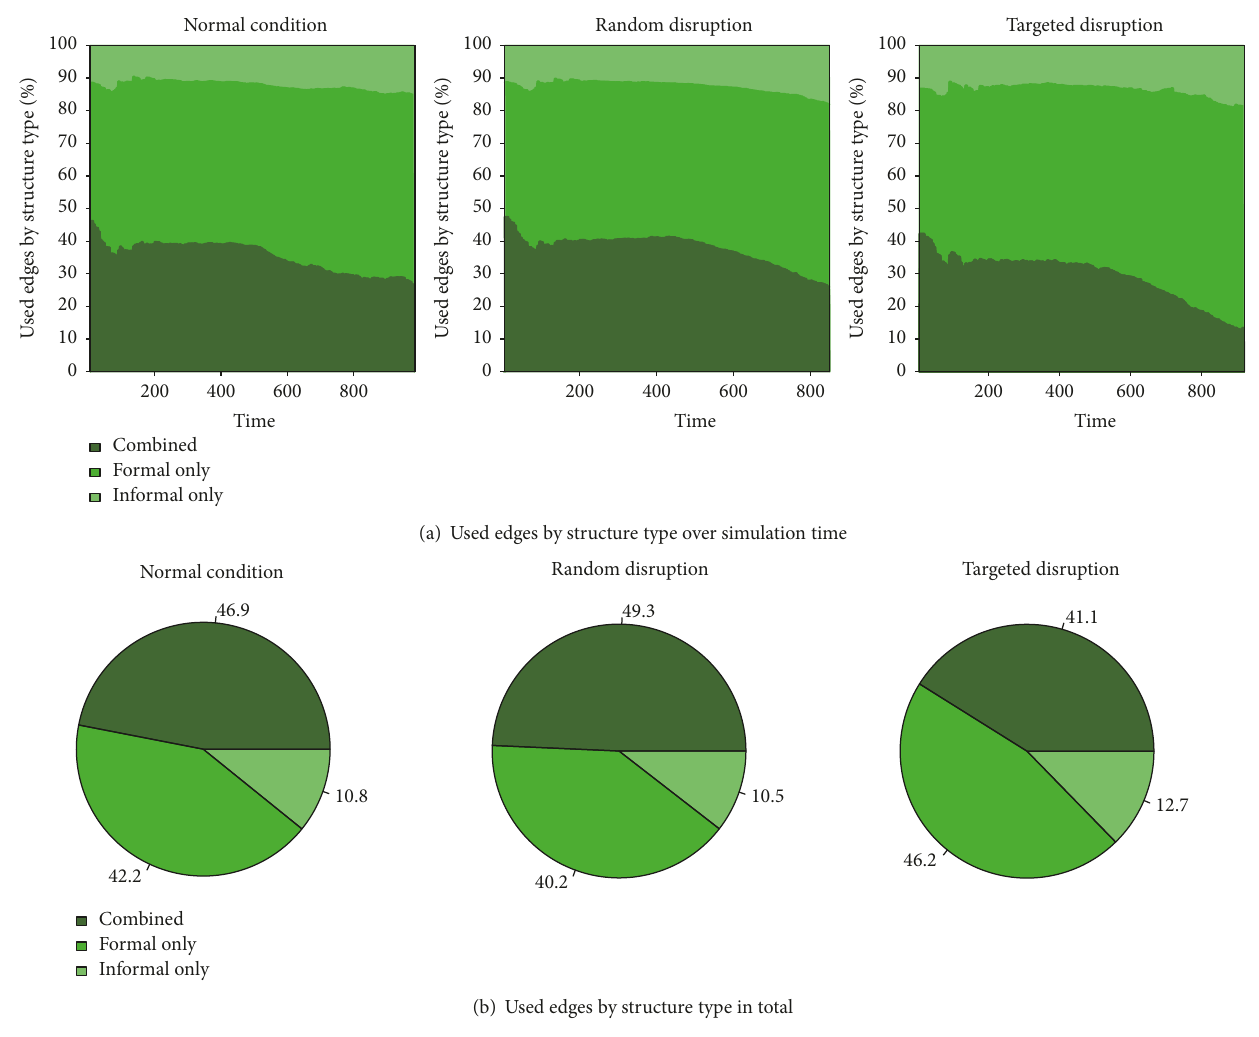
Figure 6: Types of edges used in normal and disrupted conditions. Table 4: Properties of nonsampled and sampled